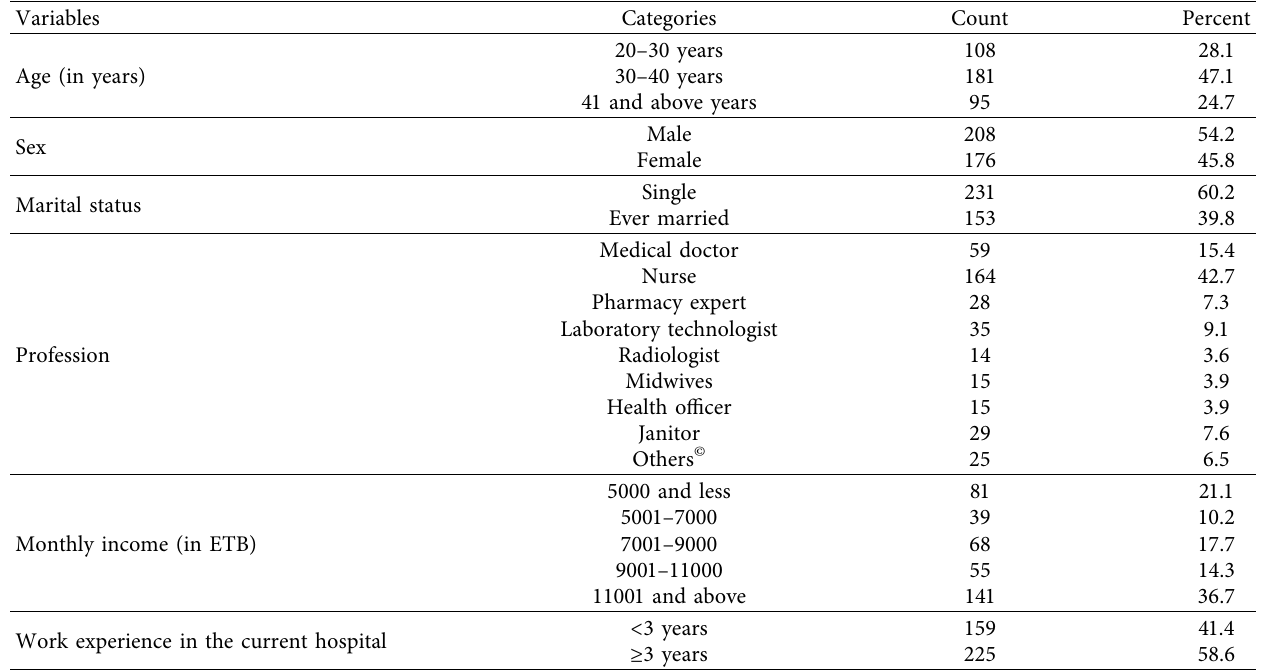
Table 1: Demographic characteristics of the study participants.